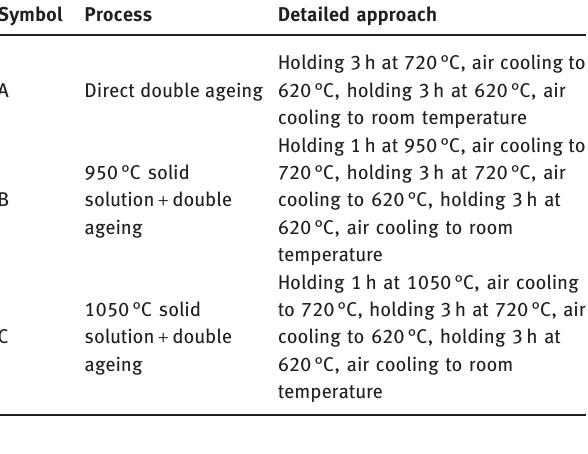
Table 2: The different heat treatment process.